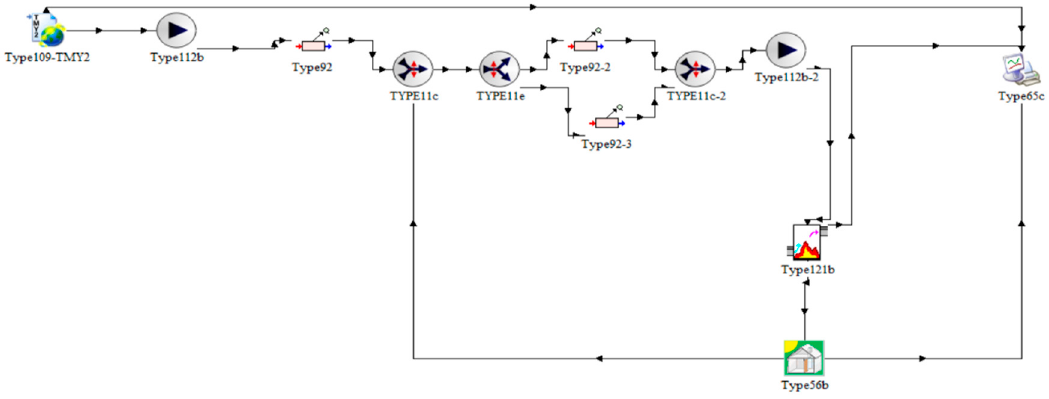
Figure 19. TRNSYS layout for option C.